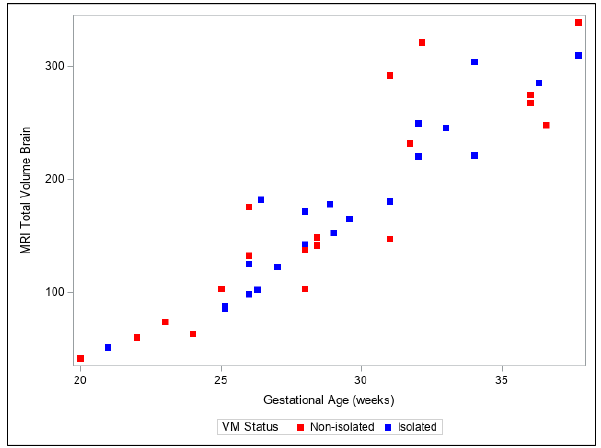
Figure 8. Three-dimensional growth trajectory measurements of total brain volume in isolated and non-isolated VM.